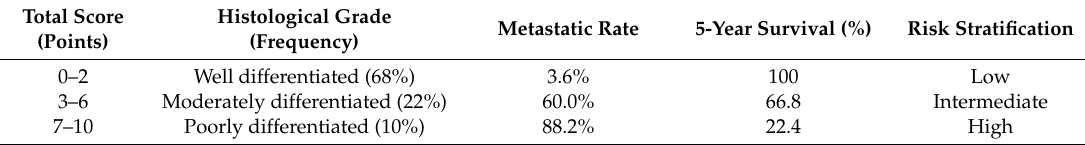
Table 3. GAPP Score and Risk